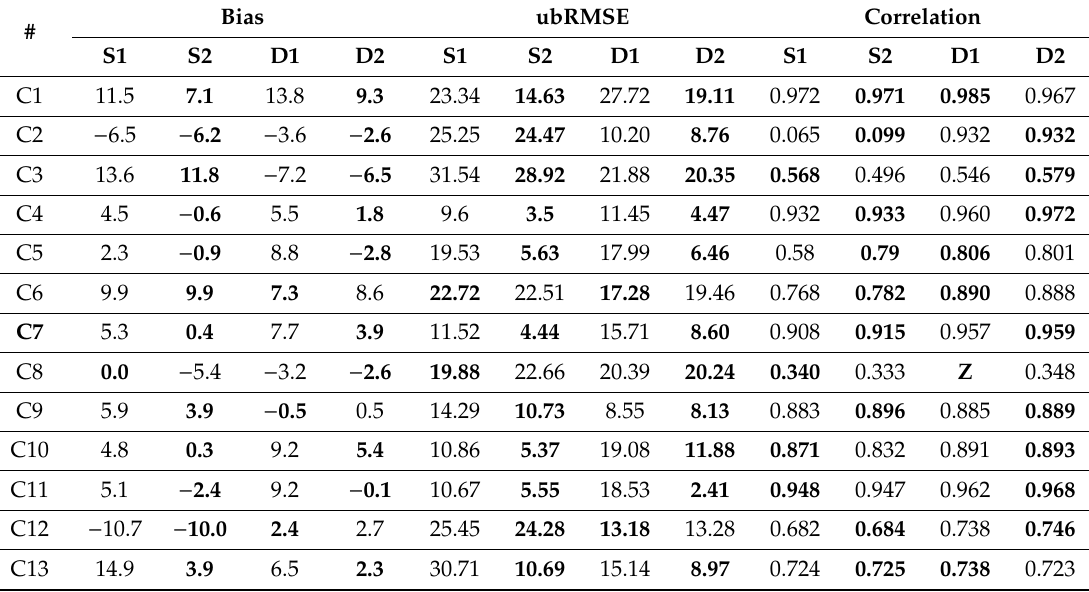
Table A4. Validation scores over USCRN